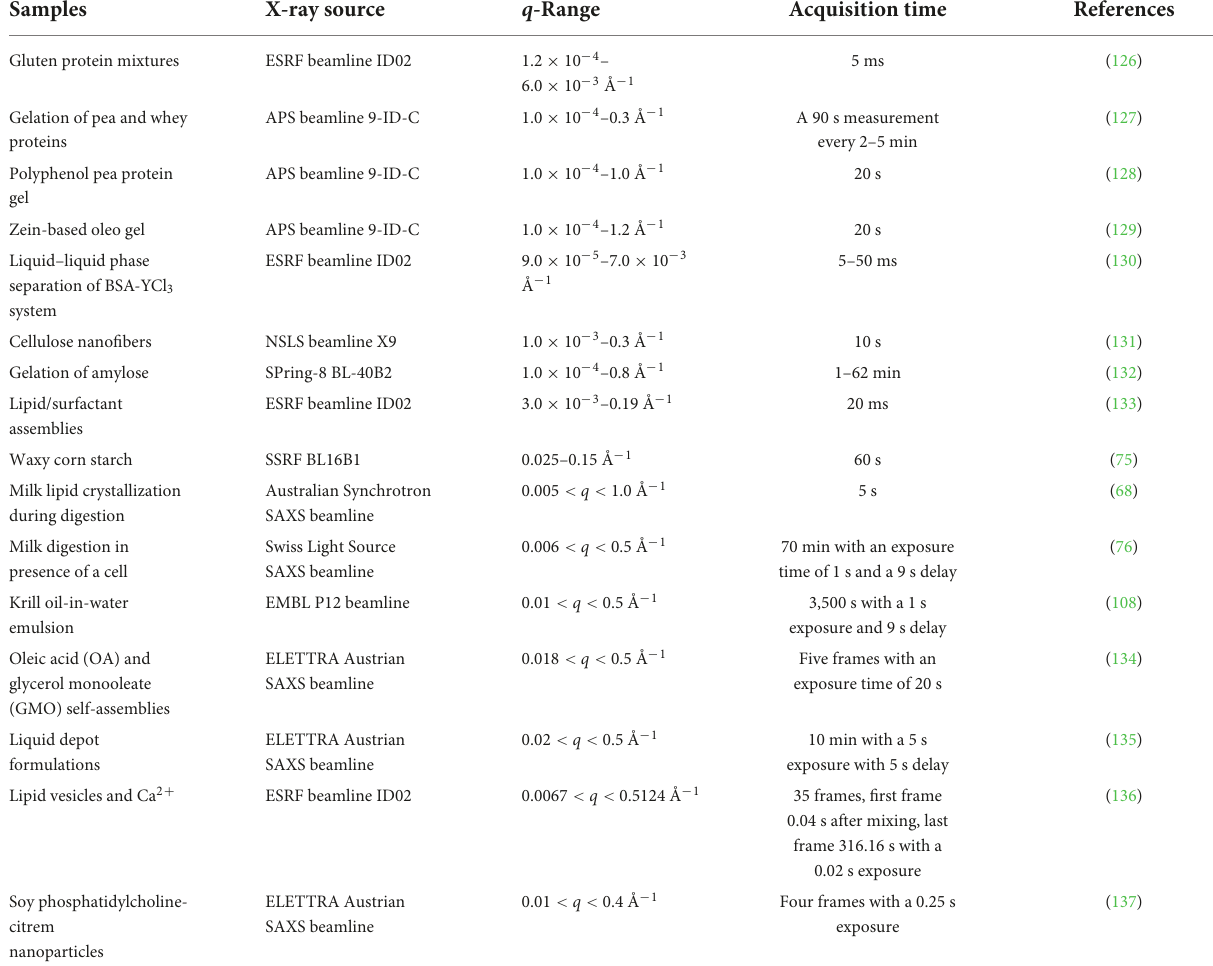
TABLE 3 Application of time-resolved small-angle X-ray scattering (TR-SAXS) at various synchrotron beamlines.